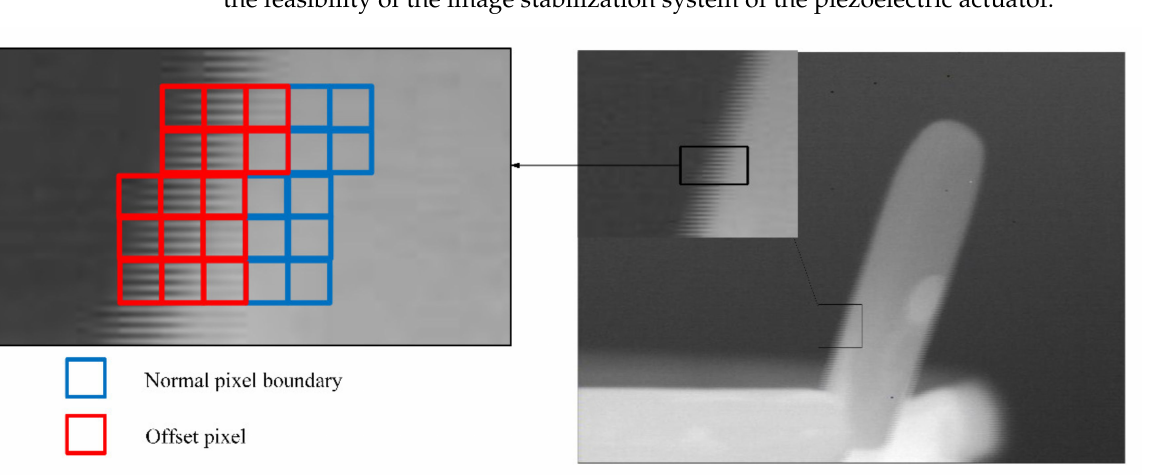
Figure 24. The infrared image under the interference